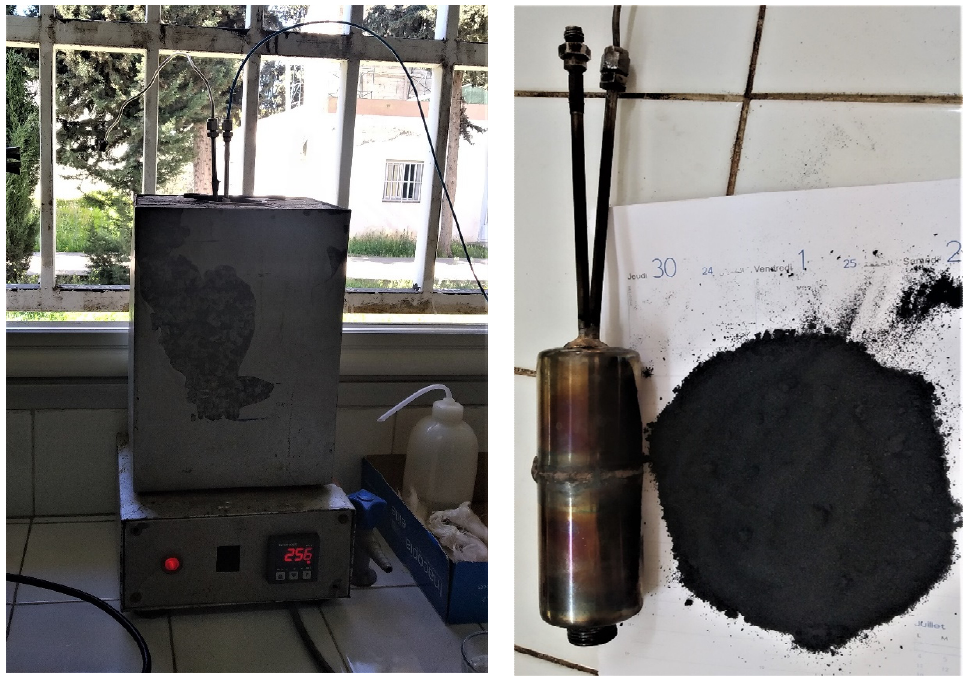
Figure 1. Reactor and furnace used to produce activated